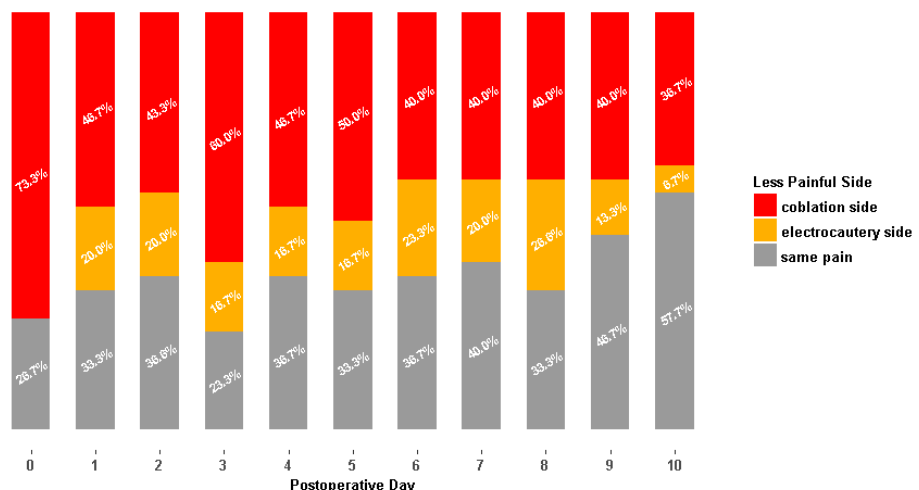
Figure 5. Less painful side (visual analogue scale ≤ 5). Majority of patients reporting less pain on the coblation side from the day of surgery through postoperative day 8 and similar pain on both sides on postoperative days 9 and